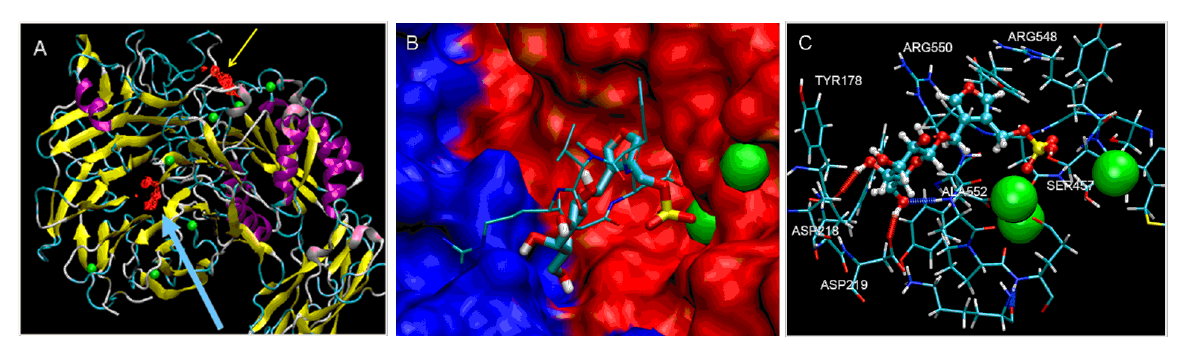
Figure 4: In silico blind-docking (A, B) and molecular dynamic simulations (C) of (4-{[( β -D-galactopyranosyl)oxy]methyl}furan-3-yl)methyl hydrogen sulfate (GSF) on the extracellular domain of the integrin α v β 3 . A: The blind-docking studies showed a preferred binding of GSF (red) to the binding site of the natural peptide ligands on α v β 3 (yellow arrow). An additional binding site was predicted to be located inside the β -propeller domain of the α chain (blue arrow). B: Close-up of the binding site between the α v (blue) and the β 3 (red) chain of the integrin showing the synthetic pentapeptide cyclo-[RGDfN(Me)V] with thin lines and GSF in broader lines. Carbon, oxygen, nitrogen and sulfur are shown in blue, red, dark blue, and yellow, res- pectively. The manganese ions are represented as green spheres. C: Molecular dynamics simulation in water of the GSF molecule showing hydrogen bonds of the galactose moiety with the amino acids in the binding site of integrin α v β 3 (Gal(OH4) with ASP218 and Gal(OH6) with ASP219/ALA552). The sulfate coordinates with one of the manganese ions.